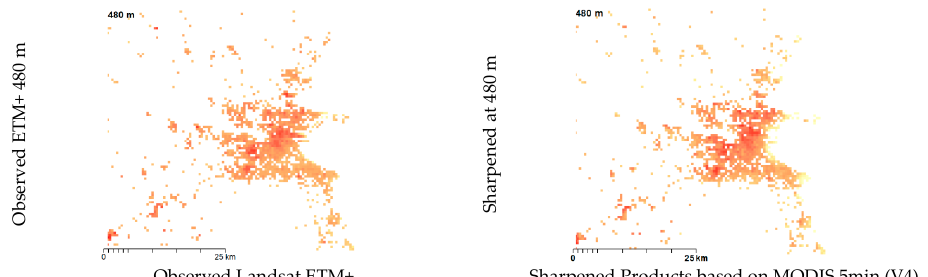
Figure 14. The left side maps are the observed land surface temperature in degrees Celsius derived from Landsat ETM+ band 6 (acquisition date 24 May 2001) at different resolution (60 to 480 m). The right side maps are the sharpened images at the different spatial resolutions, obtained by using the improved DisTrad methodology to downscale the MOD11_L2 (5-min–V4) 960 m resolution image.